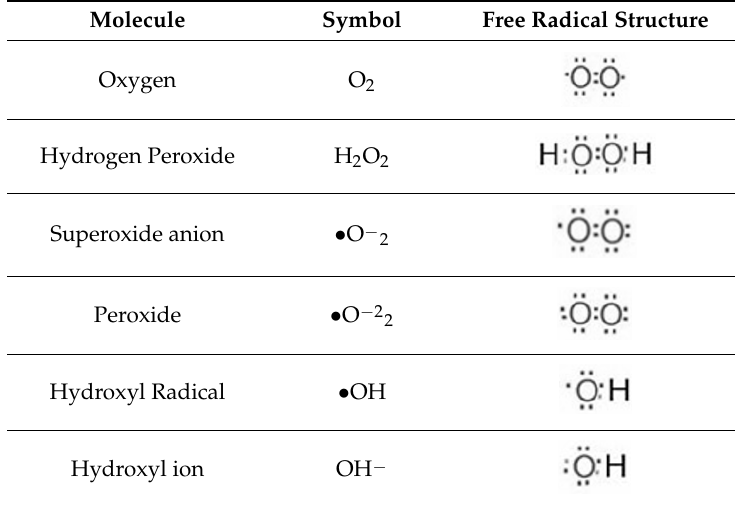
Table 1. Some examples of molecules and corresponding free radicals.